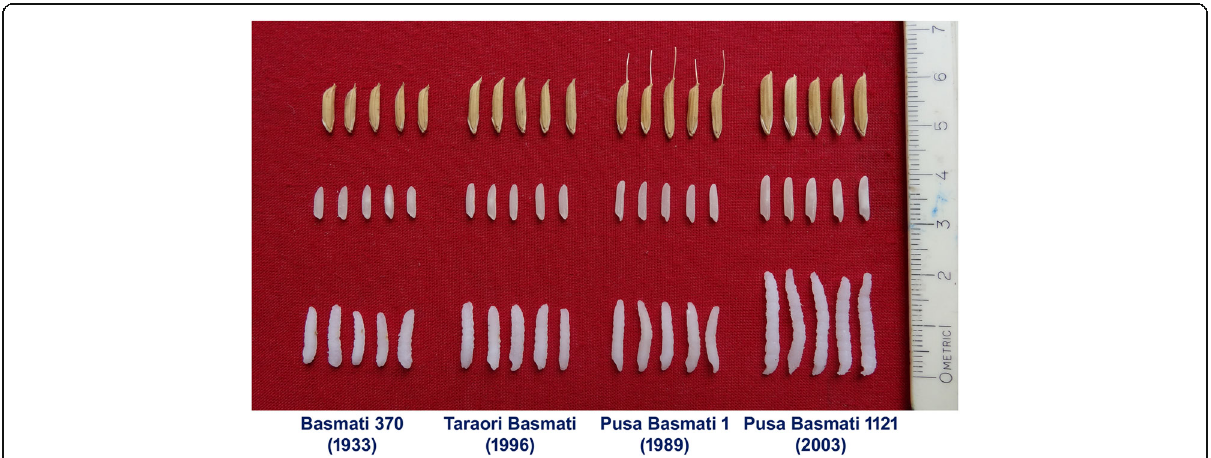
Fig. 5 Gradual improvement in grain and cooking quality of Basmati rice varieties: a journey of decades